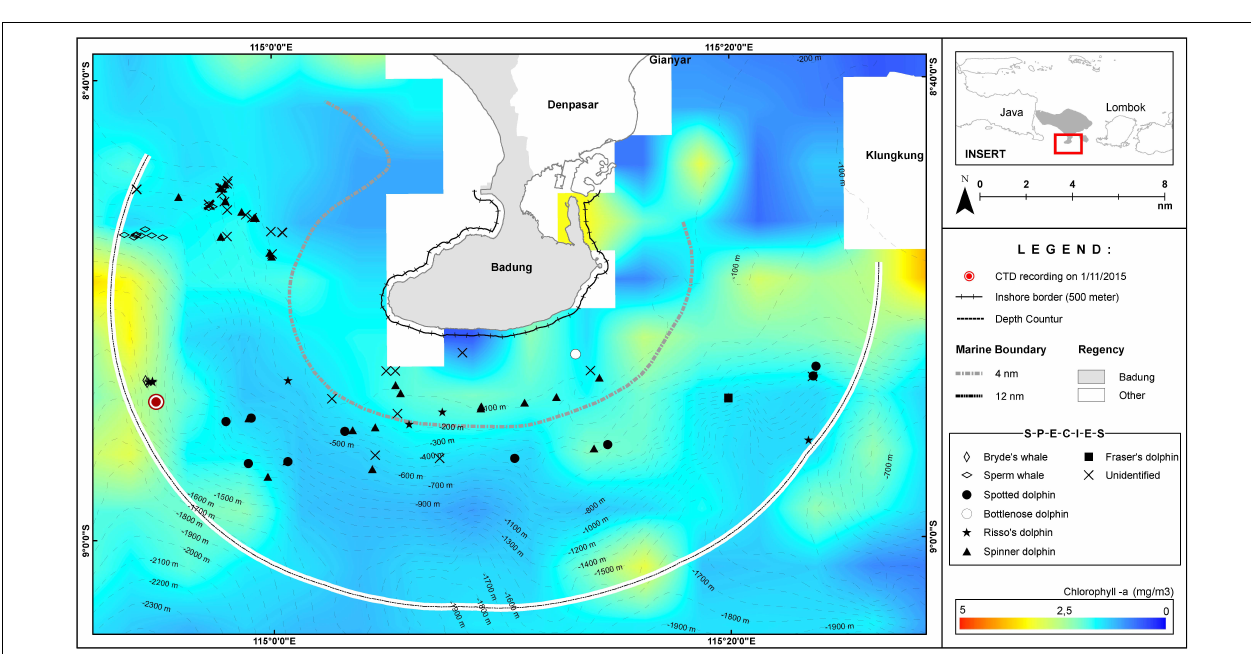
all Bali provincial waters (12 nm, 22 km) for the same